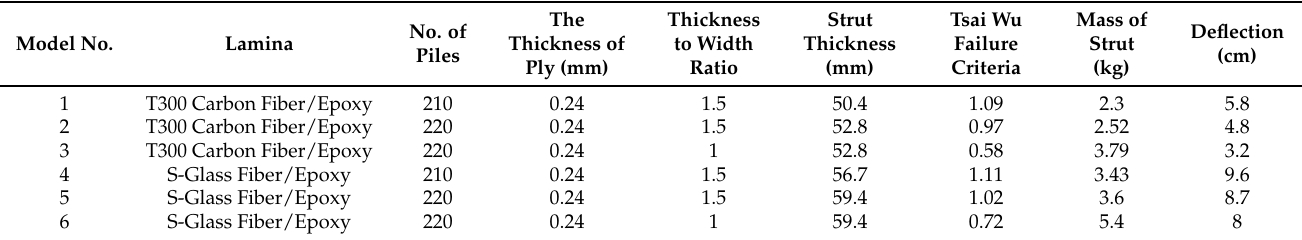
Table 7. Parametric study of different models of straight main landing gear strut composed of S-glass fiber/epoxy and T300 carbon fiber/epoxy upon impact.